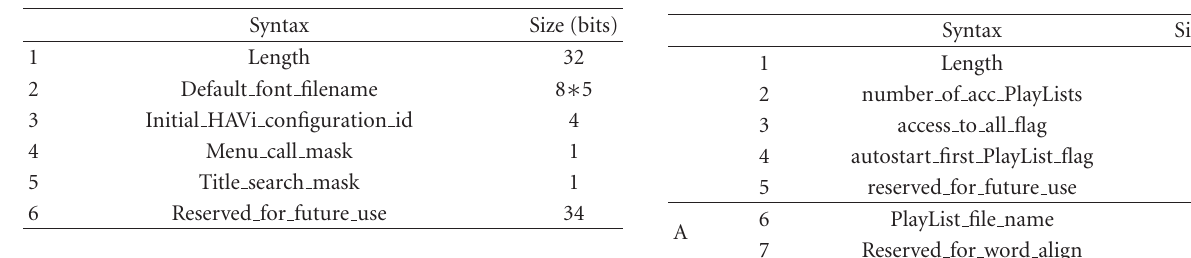
Table 5: Terminal information.